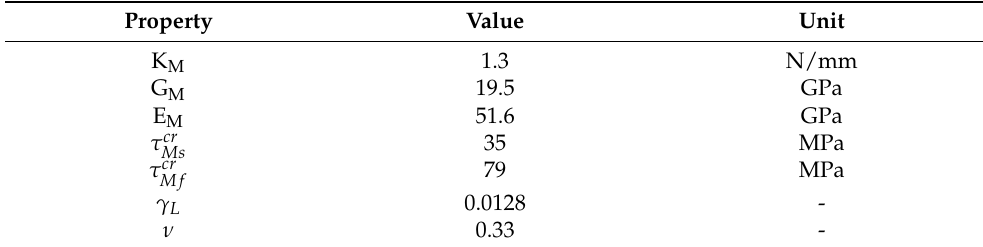
Table 3. Specific material values for martensite.